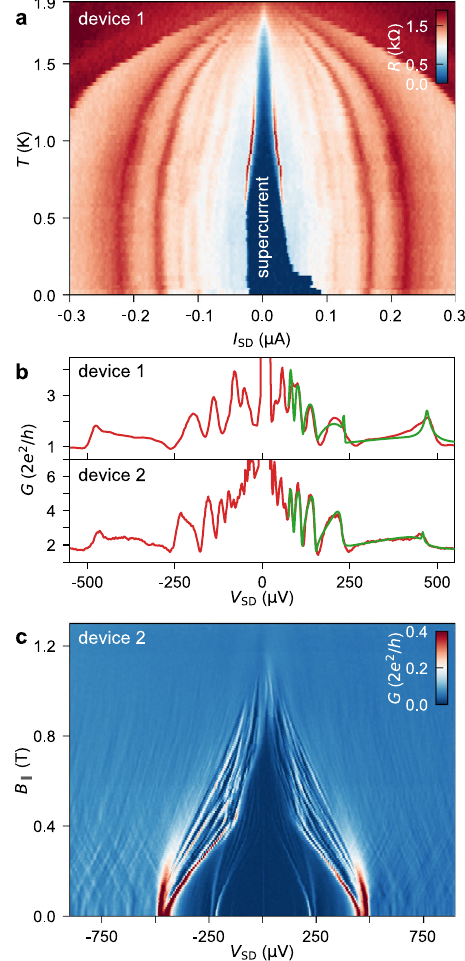
Fig. 2 TEM analysis of the InSb/Al interface. a False-colour SEM image of an InSb nanowire Josephson junction. b Schematic of the measurement setup. The back-gate voltage, V BG , is applied to the p + -doped Si substrate to tune the electron density in the nanowire. c Cross-sectional EDX elemental composite image of the 111 ½ (cid:2) InSb nanowire covered with the Al layer and a protective layer of SiN x . d Line-cuts of the integrated elemental counts within the orange box in panel c . e High-resolution bright- fi eld scanning TEM image of the InSb/Al interface at the location indicated by the blue box in panel c .